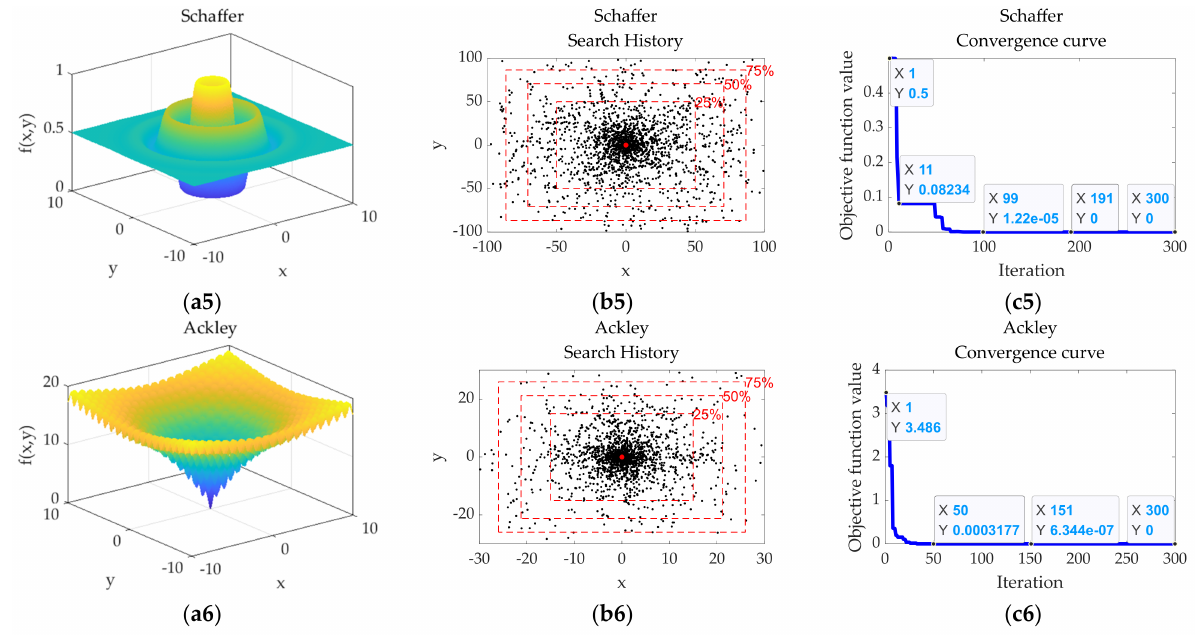
Figure 4. The standard test results of the OMO algorithm when the dimension is 2. ( a1 – a6 ) Parameter space schematic diagram of the i th test function; ( b1 – b6 ) Search history diagram of the OMO algorithm in the i th test function with percentage range mark; ( c1 – c6 ) The optimal value of the function varies with the number of iterations graph of the OMO algorithm in the i th test